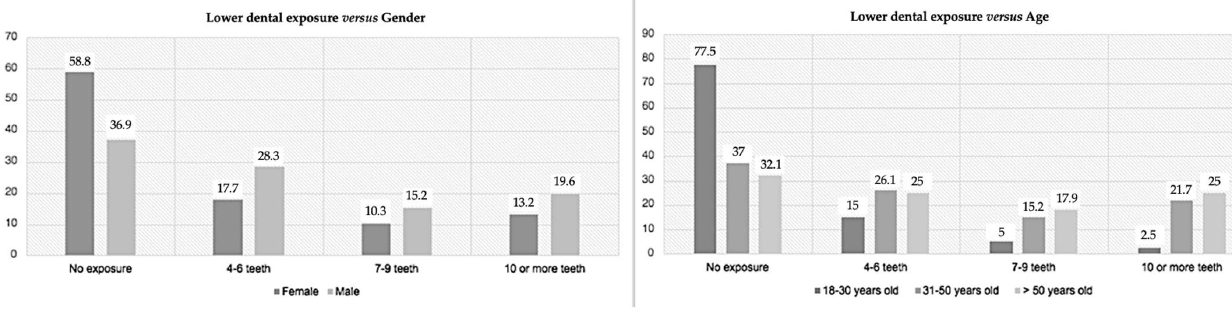
Figure 6. Prevalence of the lower teeth exposure according to gender ( left ) and age ( right ).